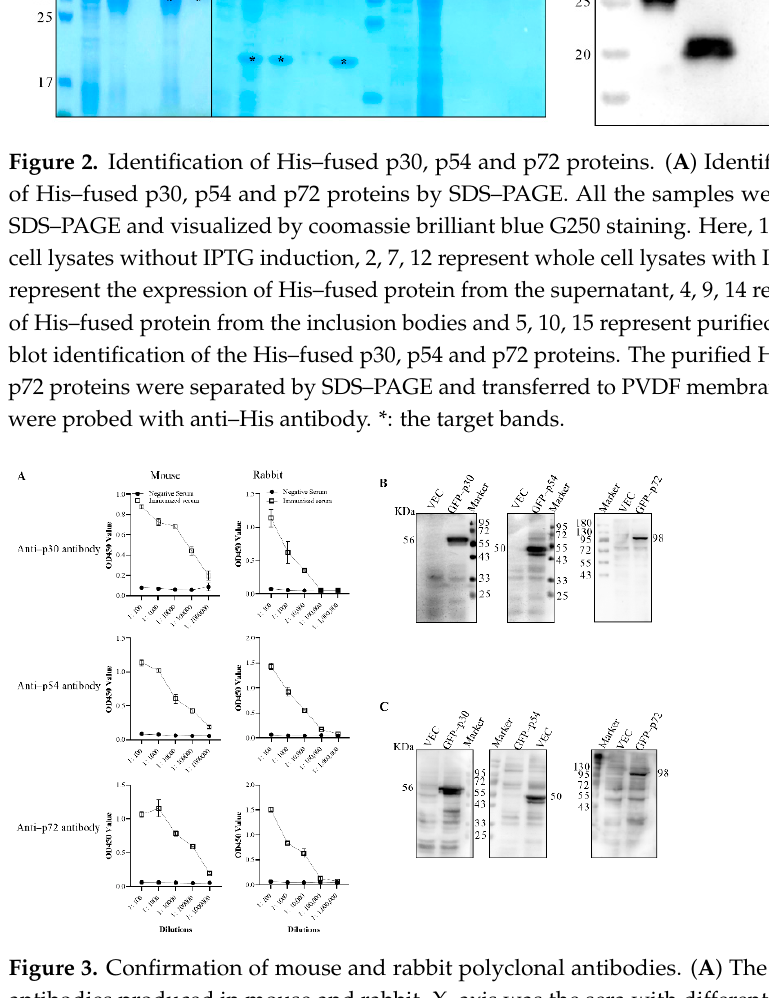
Figure 2. Identification of His–fused p30, p54 and p72 proteins. ( A ) Identification of purification of His–fused p30, p54 and p72 proteins by SDS–PAGE. All the samples were electrophoresed on SDS– PAGE and visualized by coomassie brilliant blue G250 staining. Here, 1, 6, 11 represent whole cell lysates without IPTG induction, 2, 7, 12 represent whole cell lysates with IPTG induction, 3, 8, 13 represent the expression of His–fused protein from the supernatant, 4, 9, 14 represent the expression of His–fused protein from the inclusion bodies and 5, 10, 15 represent purified proteins. ( B ) Western blot identification of the His–fused p30, p54 and p72 proteins. The purified His–fused p30, p54 and p72 proteins were separated by SDS–PAGE and transferred to PVDF membrane. The target proteins were probed with anti–His antibody. *: the target bands.